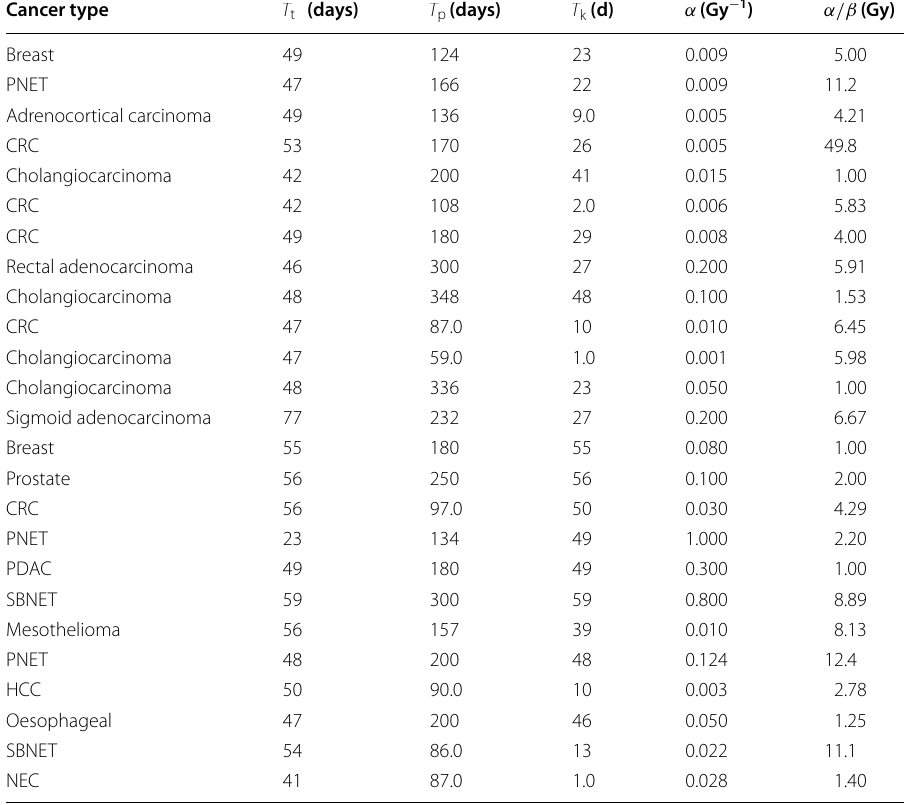
Table 1 Summary of estimated radiobiological